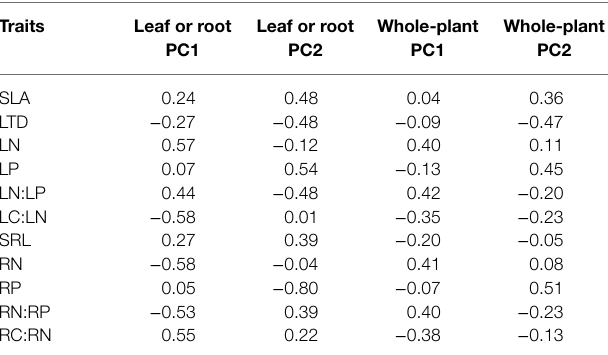
FIGURE 2 | a forb (closed circle), grass (triangle), or woody species (open square) in the two-dimensional trait space. SLA, specific leaf area; LTD, leaf tissue density; LN, leaf nitrogen content; LP, leaf phosphorus content; LN:LP, leaf N:P ratio; LC:LN, leaf C:N ratio; SRL, specific root length; RN, fine-root nitrogen content; RP, fine-root phosphorus content; RN:RP, fine-root N:P ratio; and RC:RN, fine-root C:N ratio. The percentages on x - and y -axis indicate the amount of variance explained by the two main